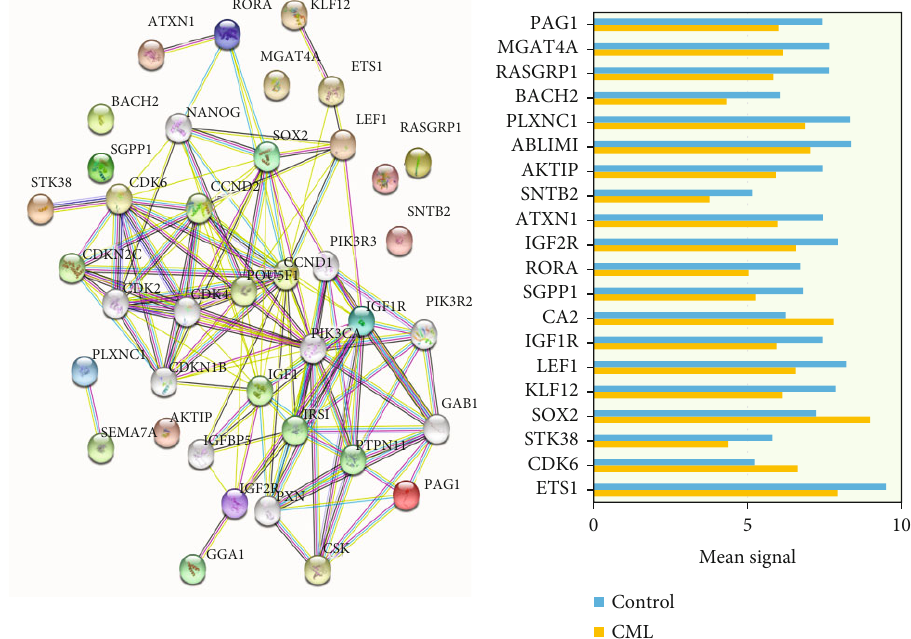
Figure 9: Analysis of coexpression and di ff erential expression of di ff erentially expressed